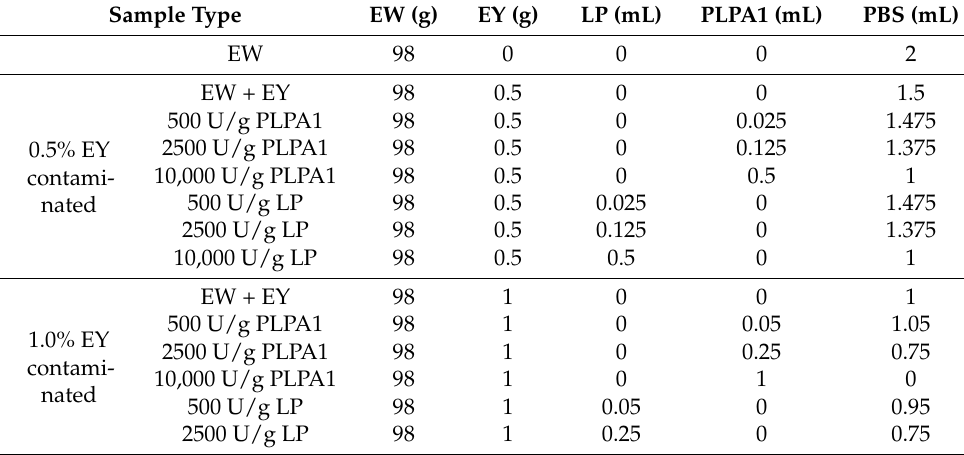
Table 2. Composition of enzymatic yolk-contaminated EW system (The density of PLPA1 and LP. solution is 1